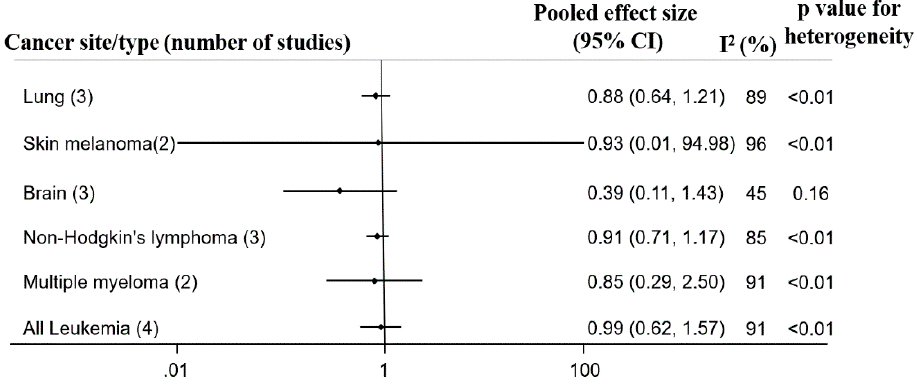
Figure 3. Forest plot of pooled effect size and heterogeneity of cohort studies evaluating cancer relative risk, incidence and mortality among residents of oil producing communities sorted by ICD.